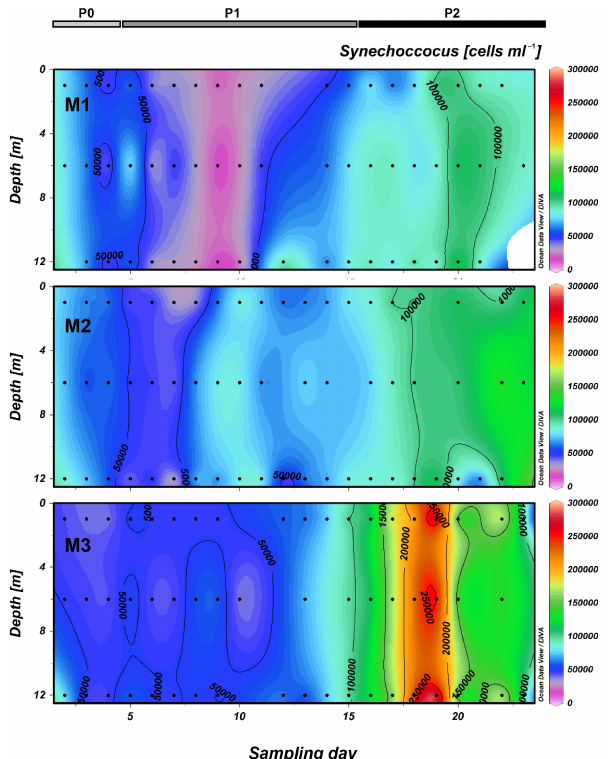
Figure 4. Synechococcus in cellsmL − 1 at each of the three depths (1, 6 and 12m) inside each mesocosm (M1, M2 and